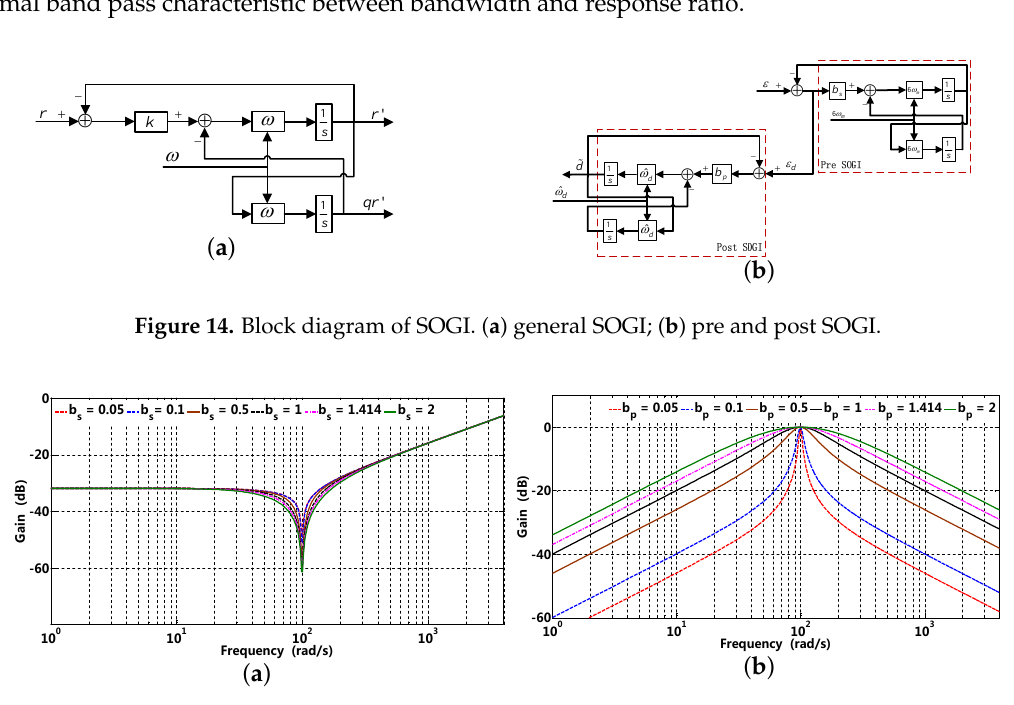
Figure 15. Gain waveforms with respect to parameter b s and b p , where corresponding parameters are ω 0 = 100 rad/s and T s = 0.1 ms, respectively. ( a ) pre SOGI; ( b ) post SOGI.